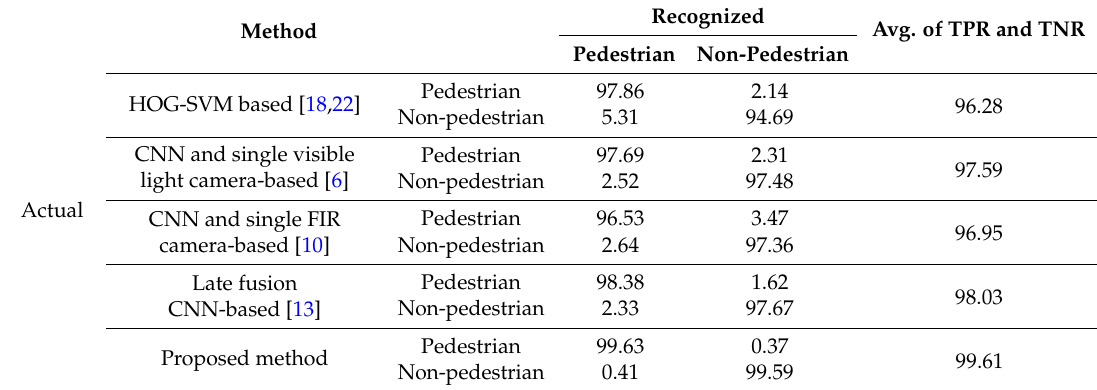
Table 8. Comparisons of classification accuracies with original DVLFPD-DB1 based on confusion matrix (unit: %).